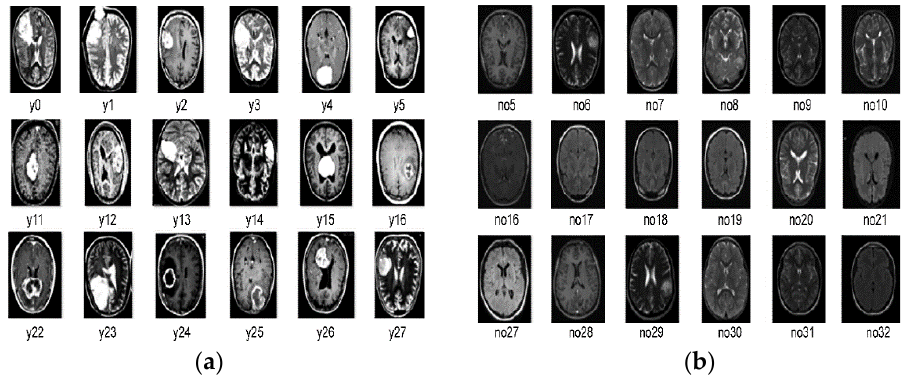
Figure 3. MRI images of two categories: ( a ) with tumor ( b ) without tumor.